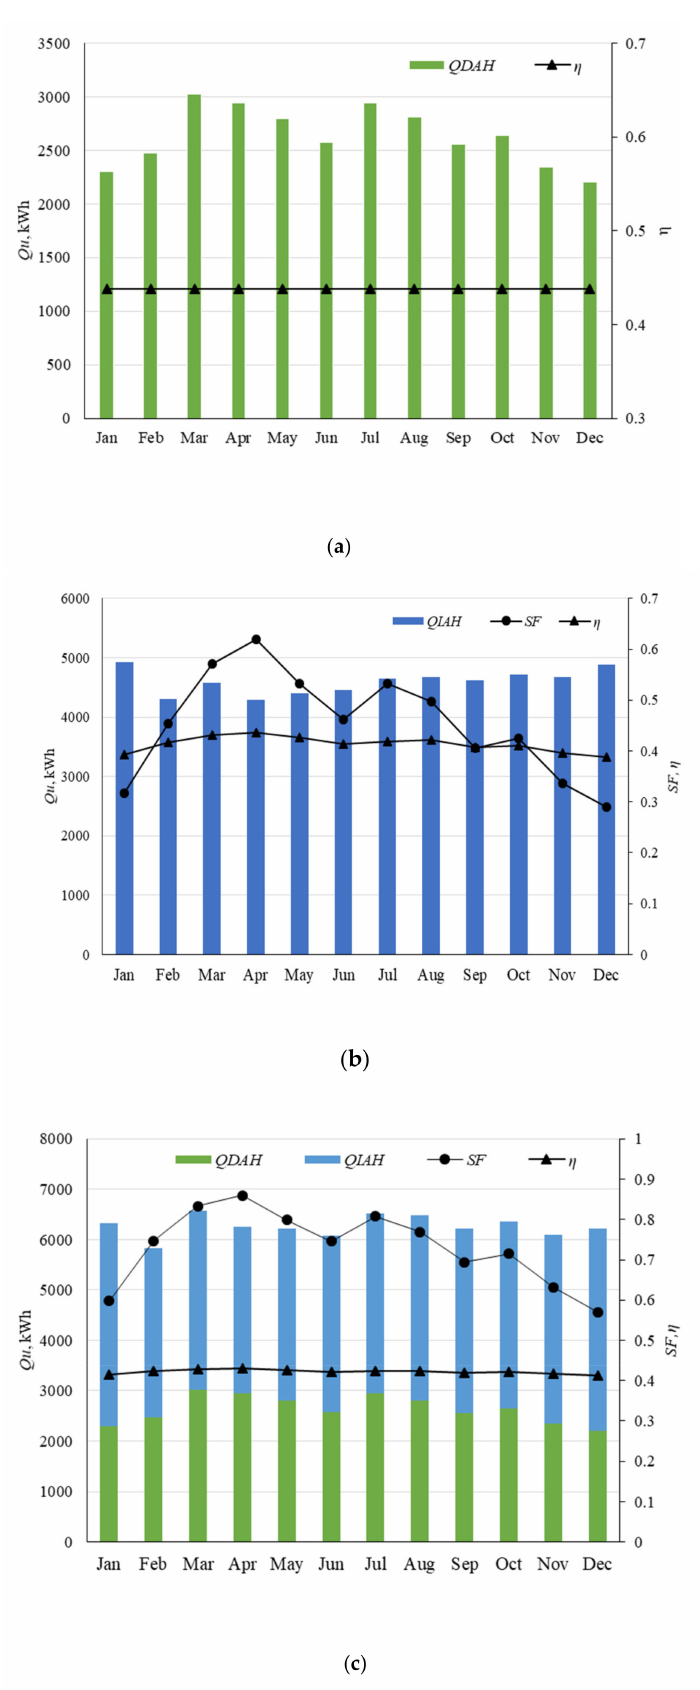
Figure 9. Useful energy Qu , efficiency η and solar fraction SF . ( a ) Mode 1; ( b ) Mode 2; ( c ) Mode